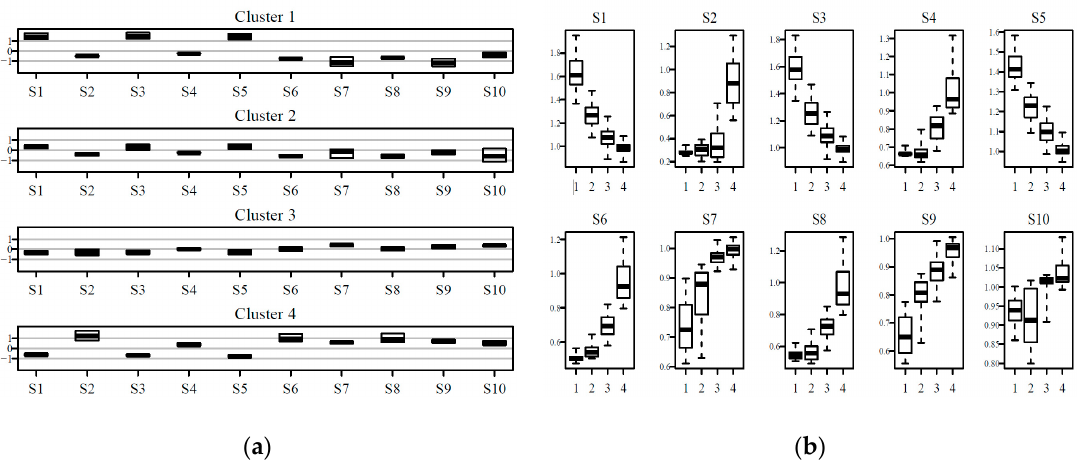
Figure 7. ( a ) Profiles of interquartile ranges and medians of sensor weights for prototypes of the building data set, belonging to each of the four clusters; weights are normalized by sensor; and ( b ) boxplots of weights of prototypes of the building data set, for the four clusters for each of the sensors